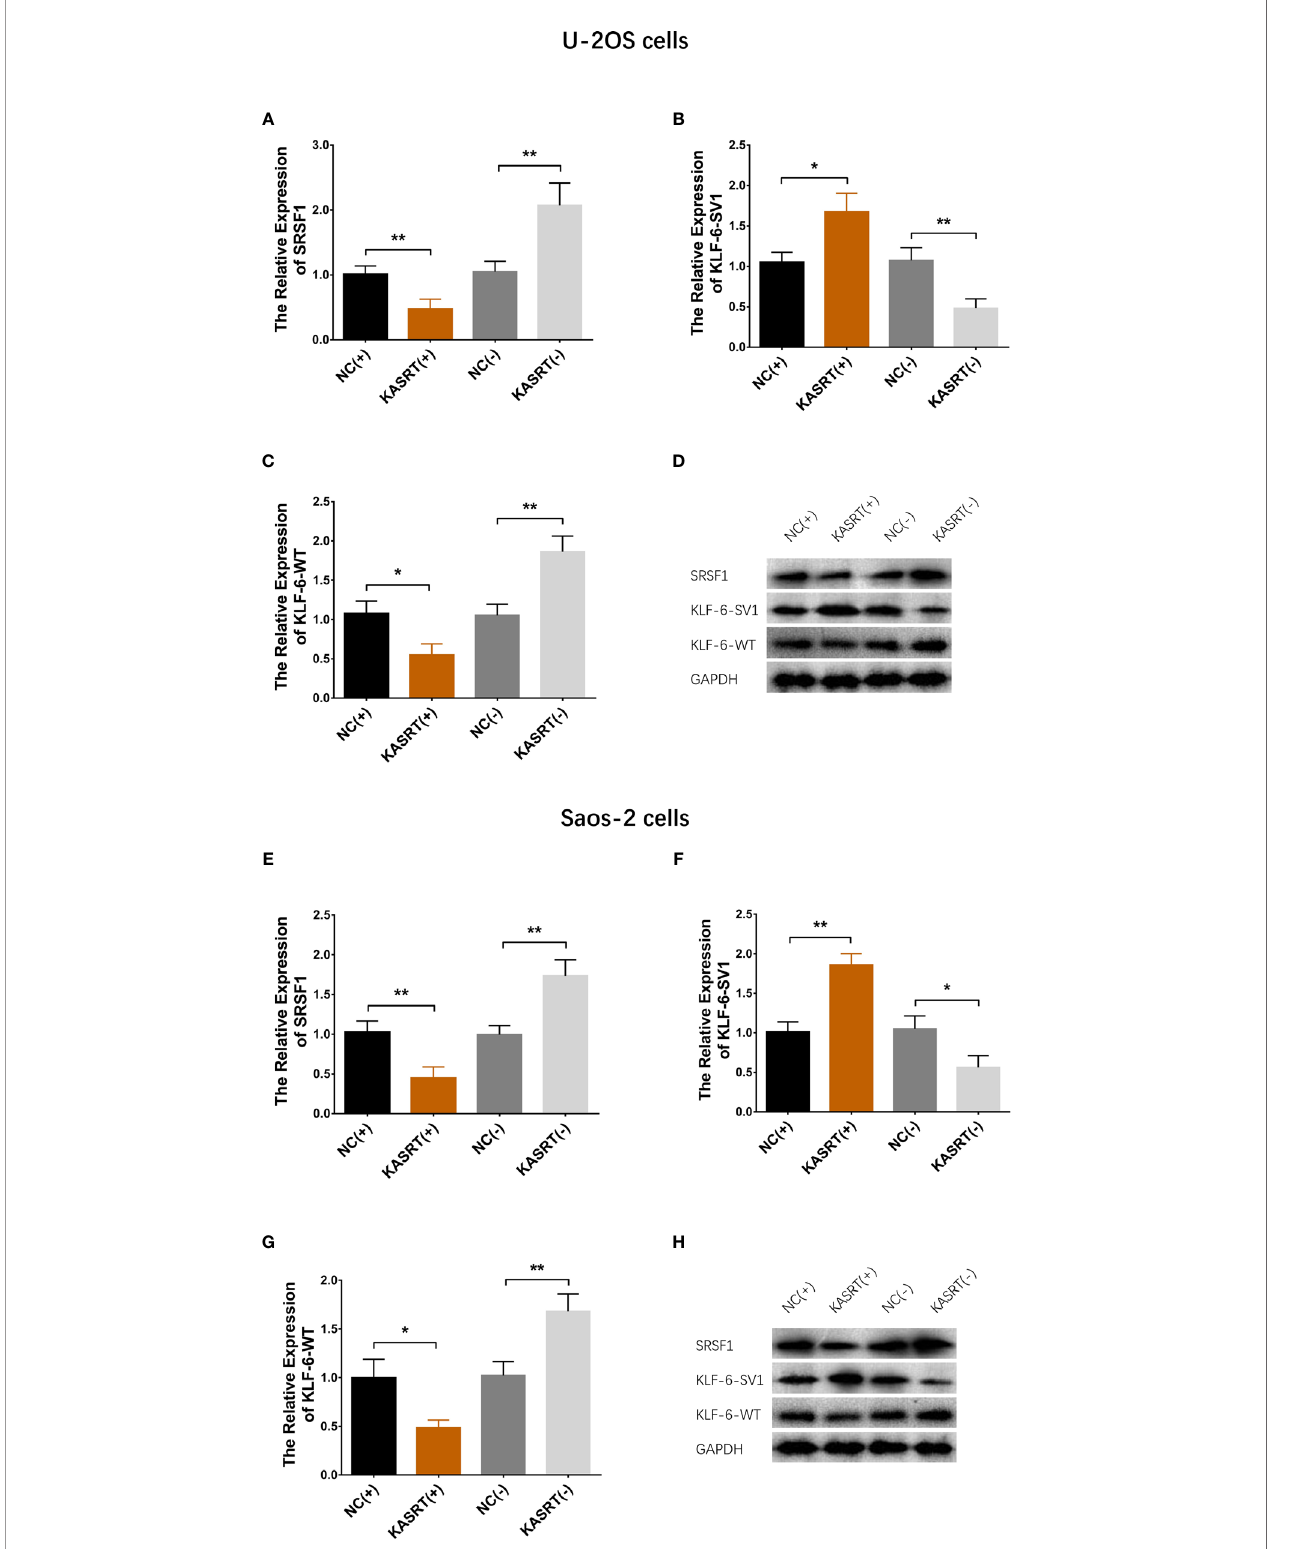
FIGURE 4 | KLF6 alternative splicing. mRNA and protein expression of SRSF1, KLF6-SV1, and KLF6-WT in U-2OS (A – D) and Saos-2 cells (E – H) . *P < 0.05, **P <